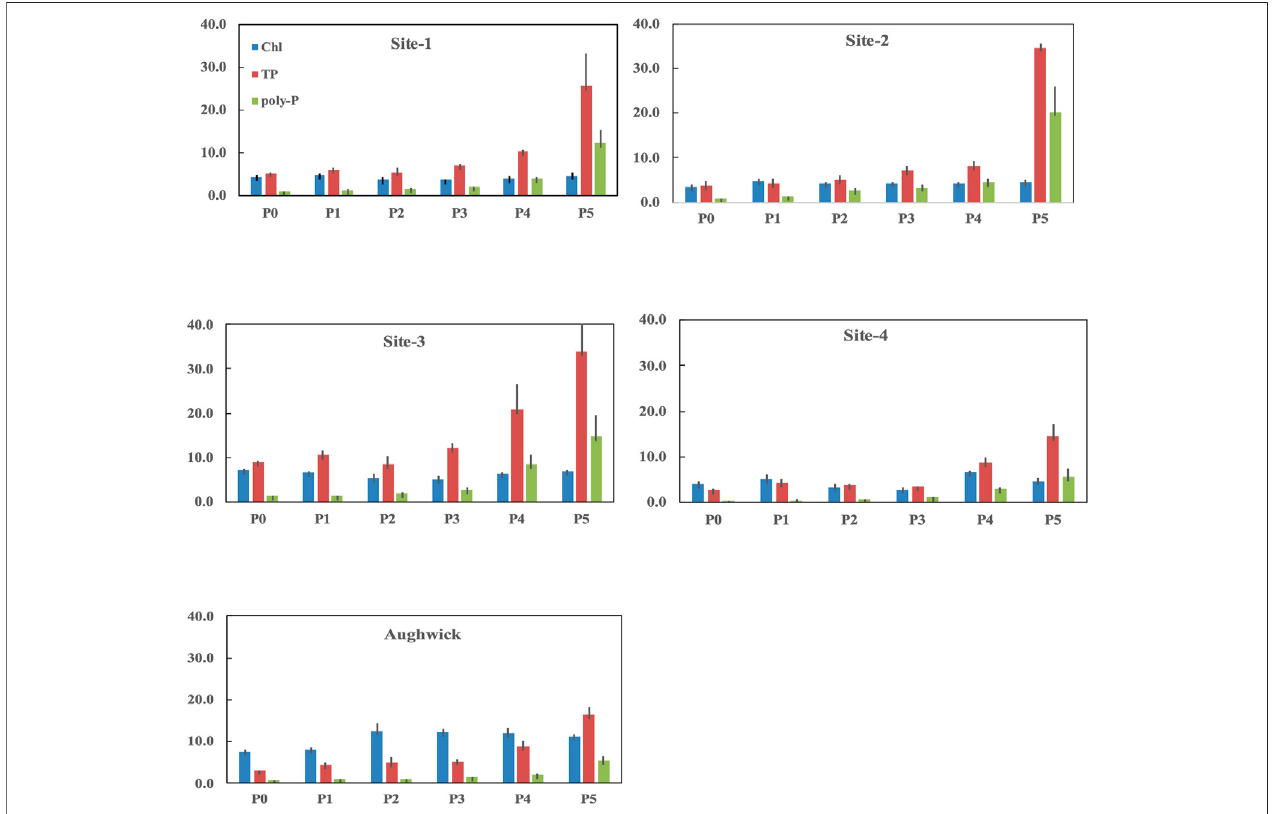
FIGURE 2 | Concentrations of chlorophyll (Chl) and phosphorus (as TP, polyP) for biol fi lms exposed to six levels of increasing P-loading (µg P m − 2 h − 1 ) released during in situ experiments carried out simultaneously at fi ve streams in July 2014 (incubation times ranged from 12 days).